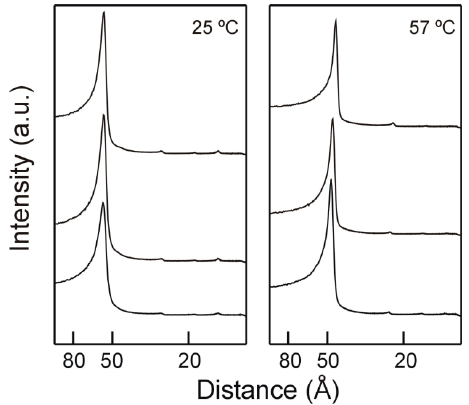
Figure 3. Small angle X-ray diffraction profiles of pure DMPE and mixtures with TMCG. Gel phase ( left , 25 °C) and liquid crystalline phase ( right , 57 °C). From top to bottom: pure DMPE, DMPE containing 0.07 mol fraction TMCG, DMPE containing 0.25 mol fraction TMCG.